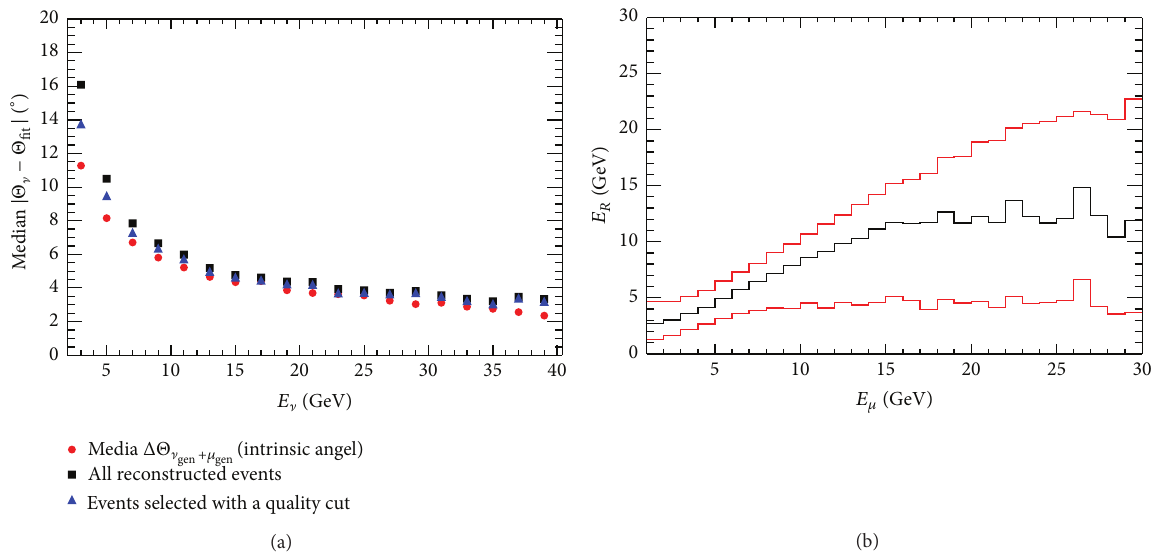
Figure 7: (a) Median of the difference between the true neutrino zenith angle and the reconstructed zenith angle calculated for all the upgoing reconstructed events with the interaction vertex inside the instrumented volume. For reference, the median of the difference between the true neutrino zenith angle and the true muon zenith angle is shown. (b) Reconstructed muon energy as a function of the muon true energy. The drawn black line gives the median value and the red lines indicate the 16% and 84% quantiles—the equivalent of a one-sigma range for a Gaussian distribution (figure from [40]).